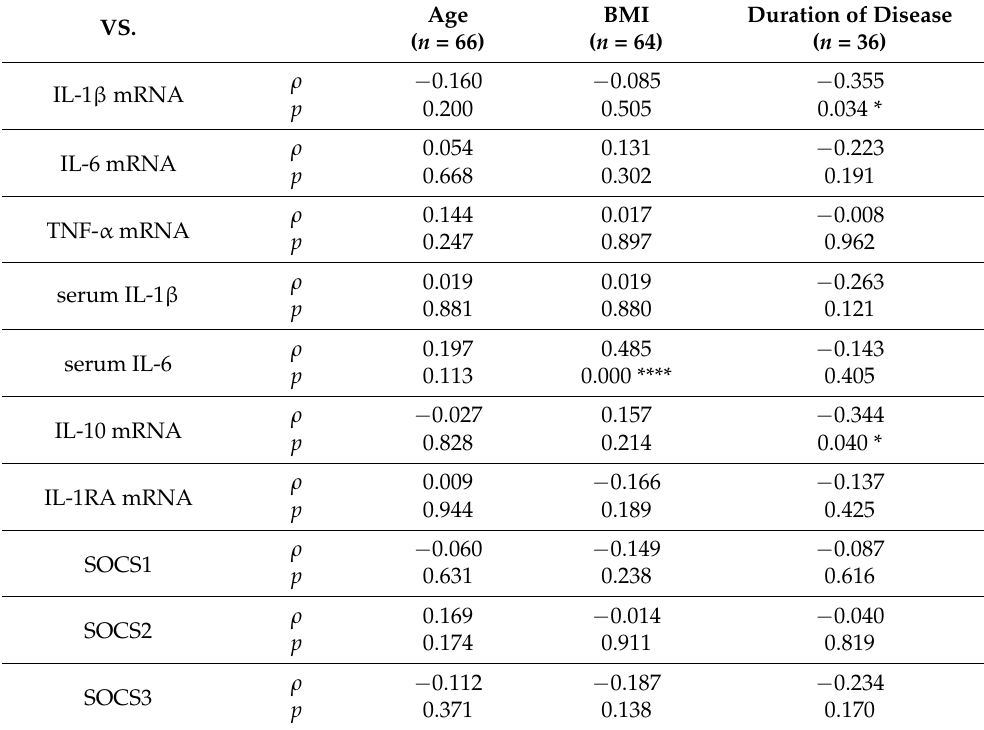
Table 2. Correlations of blood cytokines and negative regulators of cytokine signaling with age, BMI and duration of disease.